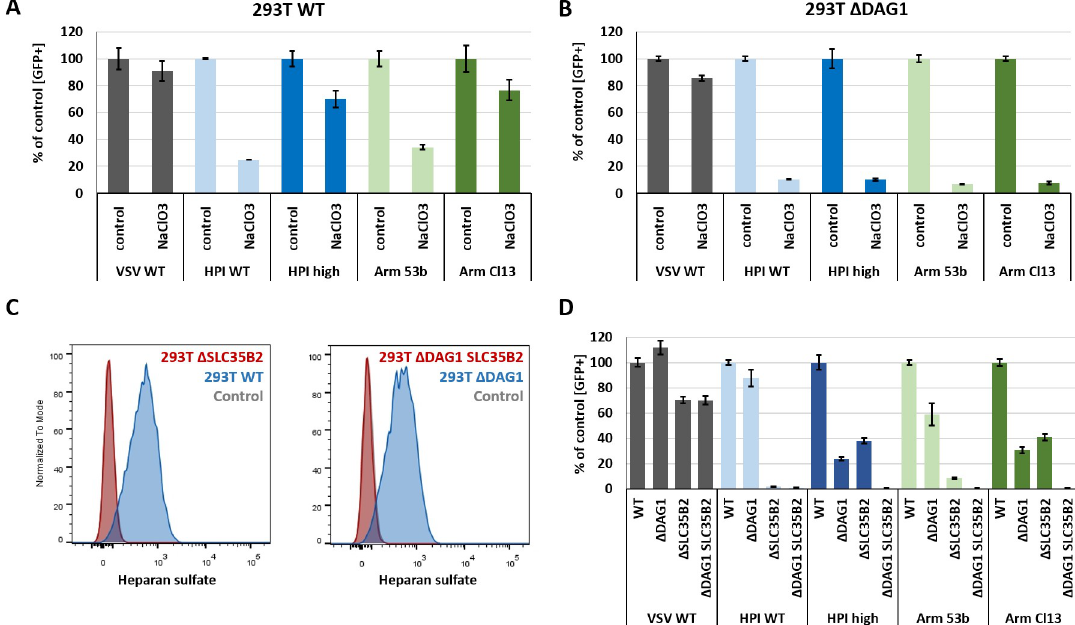
Fig 5. Chemical inhibition of sulfation and SLC35B2 knockout blocks infection of VSV-GP variants. For chemical inhibition, (A) 293T WT and (B) Δ DAG1 cells were cultured for 2 weeks in the presence of 30 mM sodium chlorate (NaClO 3 ) in complete growth medium. (C) Knockout of SLC35B2 in 293T WT ( Δ SLC35B2 ) and DAG1 deficient cells ( Δ DAG1 SLC35B2 ) was confirmed by heparan sulfate staining and flow cytometry analysis. Sodium chlorate treated and (D) knockout cells were infected at an MOI of 1 for 1 h at 37˚C with VSV WT and low or high affinity VSV-GP variants. Infection was analysed by flow cytometry of eGFP signal 15 h p.i. Shown are the means ± SD of three replicates.